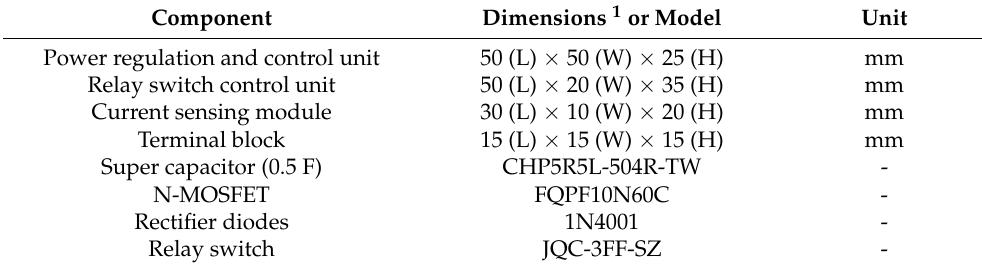
Figure 11. Hardware set-up of the energy harvesting and storage module with operation mode control for the Bowdencable-actuated knee exoskeleton. Table 2. Geometric dimensions of the major components in the energy harvesting